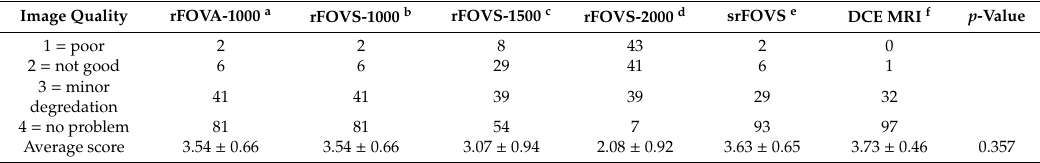
Table 2. Comparisons of image quality score among acquired reduced field-of-view di ff usion-weighted images b -value 1000 s / mm 2 (rFOVA-1000), synthetic reduced field-of-view di ff usion-weighted images, and dynamic contrast-enhanced magnetic resonance images (DCE